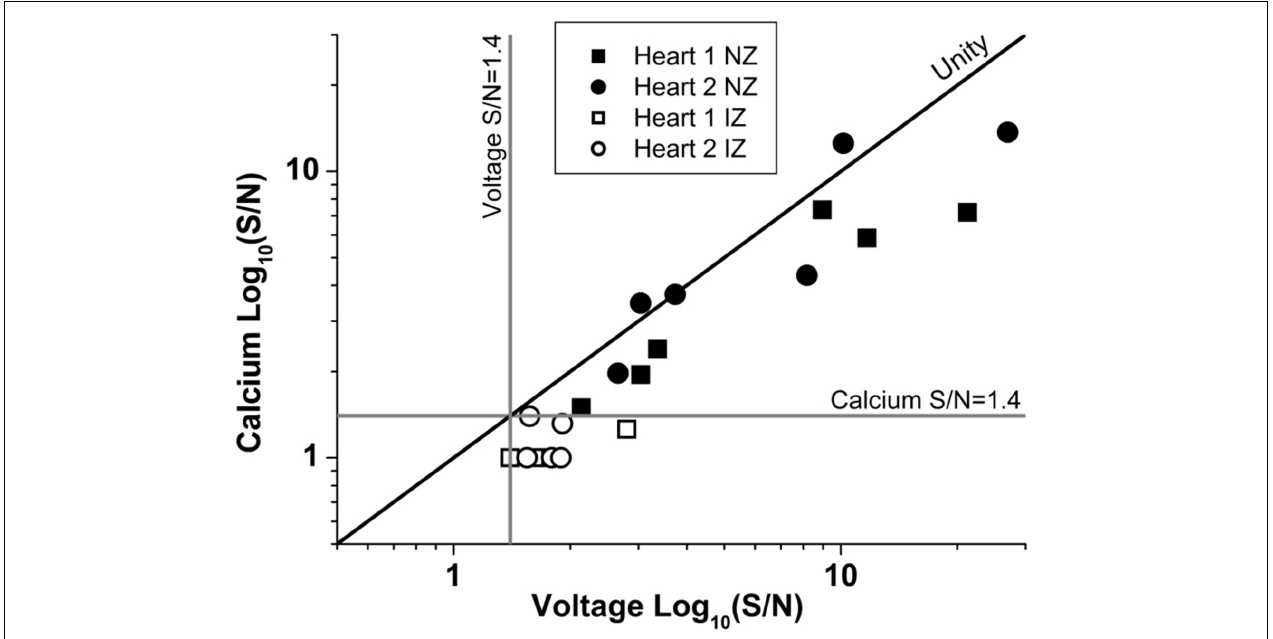
FIGURE 9 | Unity of action potential and calcium transient signal-to-noise. The signal to noise of AP and CaT plotted against one another for two example hearts from normal zone (NZ) (closed symbols) and ischemic zone (IZ – open symbols). CaT signal was on average 76% of the equivalent AP signal at all depths and remained below the detection threshold for calcium signals in the